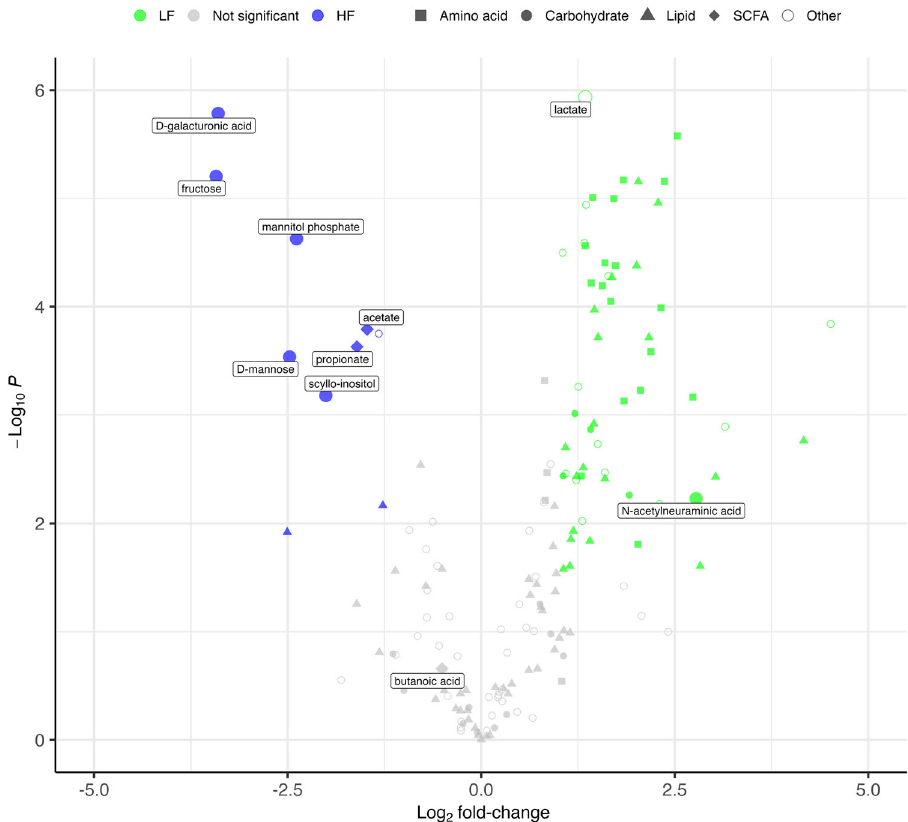
Fig. 5 Differentially abundant metabolites in the GI tract in response to inulin and pectin. Volcano plot of detected metabolites. Signi fi cantly differentially abundant metabolites ( q value < 0.05, |log 2 fold-change| > 1.0) are labeled and colored green or blue, while metabolites with no signi fi cant difference between groups are colored gray. A positive (green nodes) or negative (blue nodes) log 2 fold- change indicates a relatively higher abundance in the LF or HF group respectively. Node shapes indicate metabolite class while nodes indicating metabolites discussed in the text are enlarged and